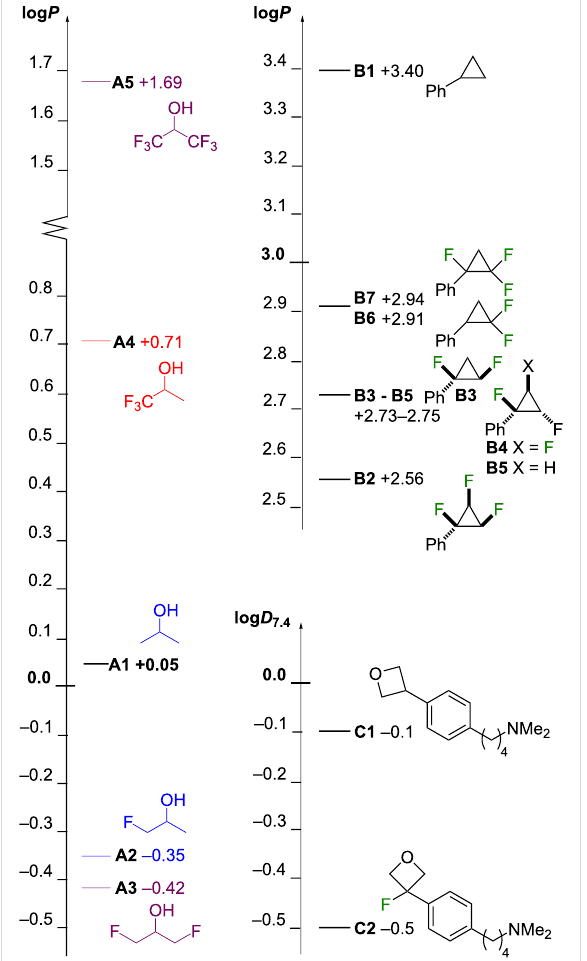
Figure 3: Lipophilicity changes upon fluorination of isopropyl, cyclo- propane and oxetane rings (Series A , C : measured experimentally via shake-flask method; series B : measured experimentally by reversed- phase